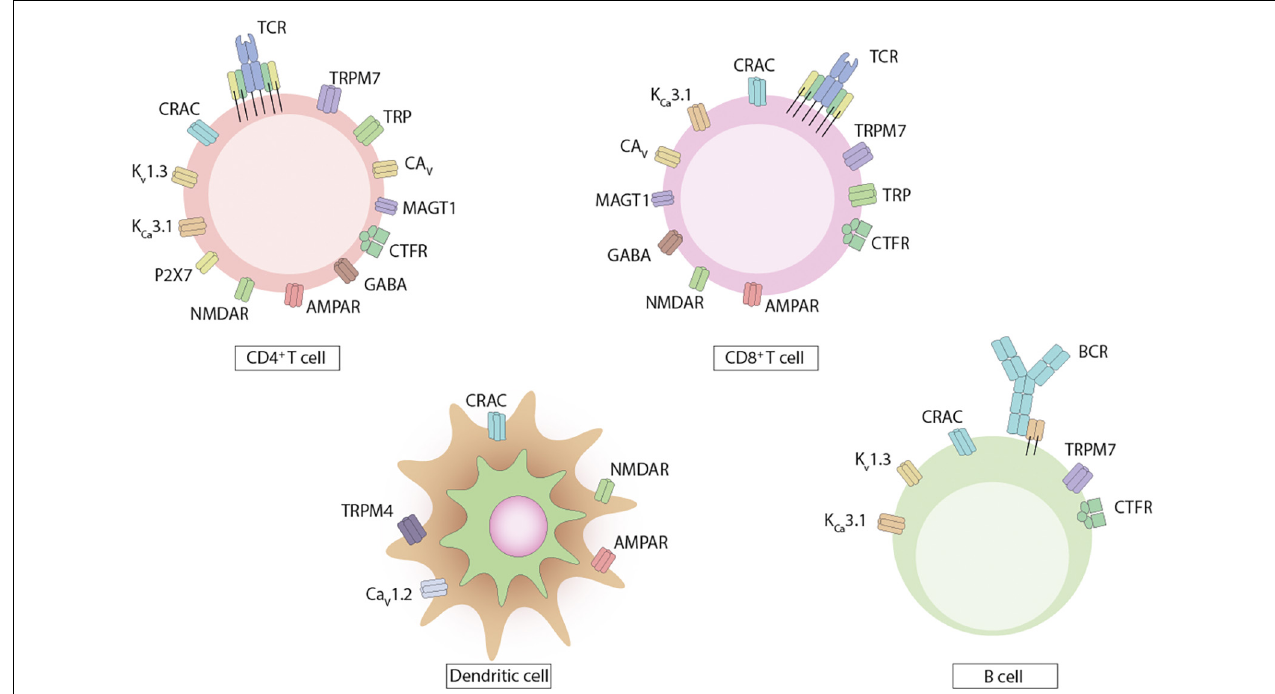
FIGURE 1 | Ion channels and transporters expressed by dendritic cells and lymphocytes. The immune cells express on their surface various types of ion channels and transporters. CD4 + and CD8 + T cells express channels for Ca 2 + , Mg 2 + , K + , and Cl − , with fewer channels reported on CD8 + T cells. B cells express channels for Ca 2 + , Mg 2 + , and K + . Dendritic cells express Ca 2 +